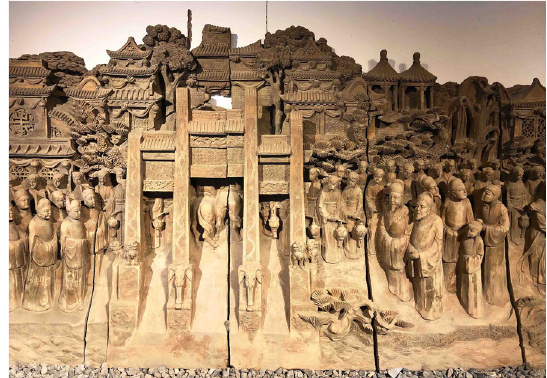
Fig. 3 Large wall relief sculpture made from